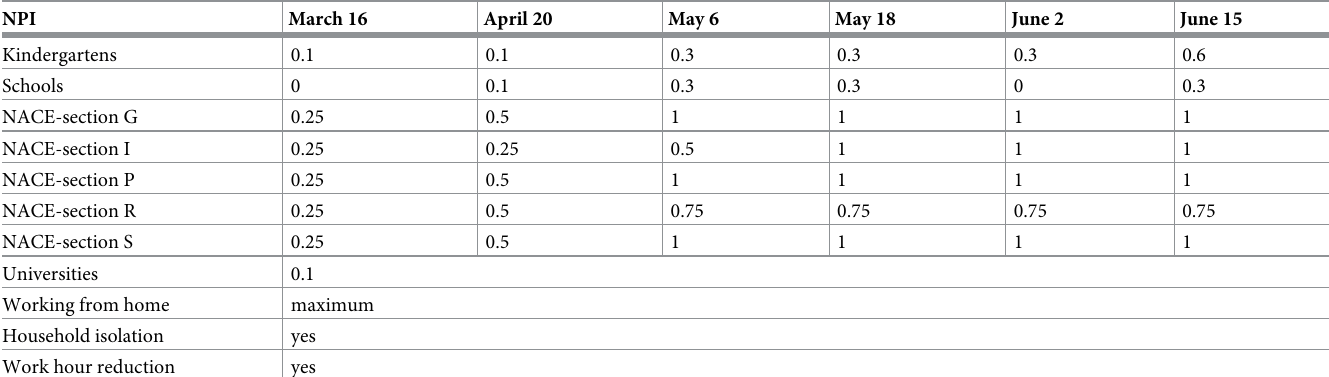
Table 1. Timetable of NPIs in baseline scenario.